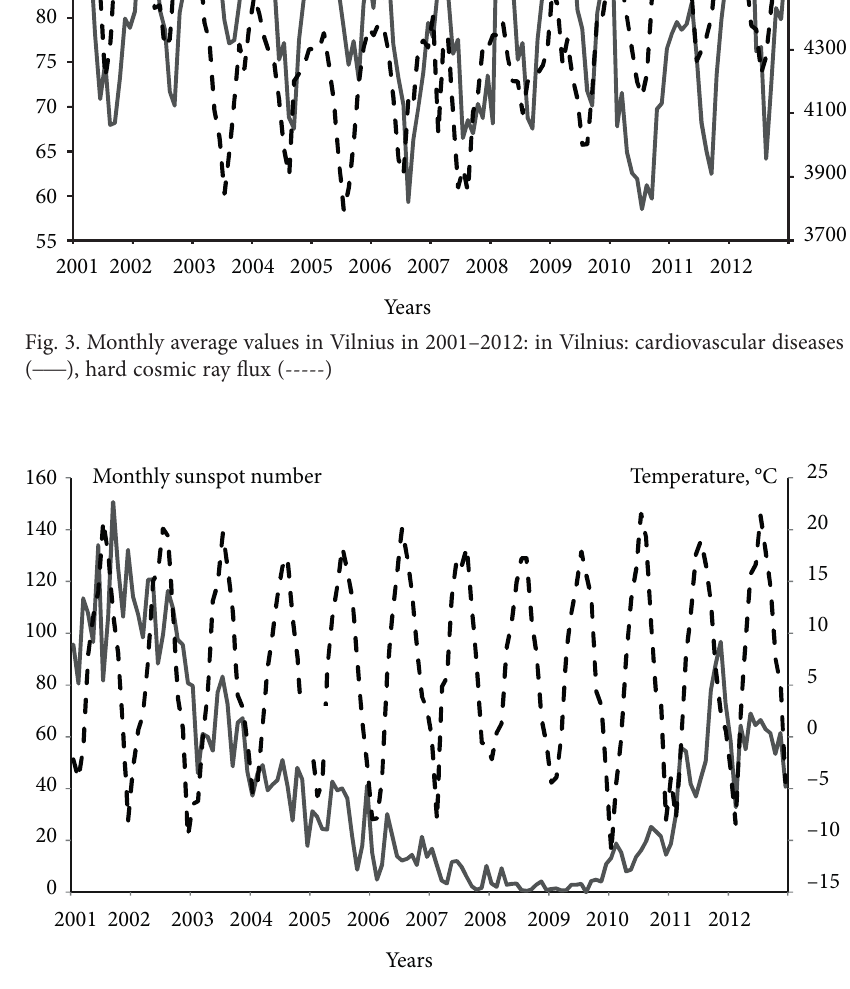
Fig. 4. Monthly average values in 2001–2012: solar spots (___), temperature in